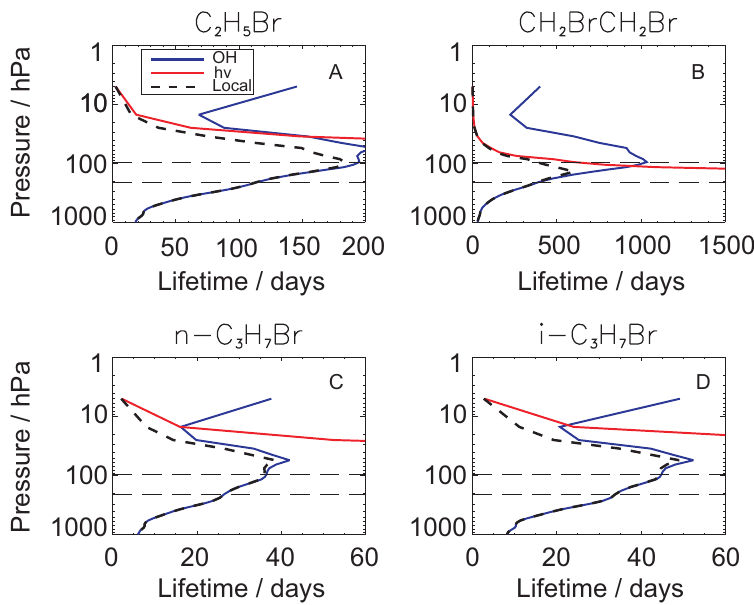
Fig. 5. Modelled mean local tropical lifetime (days) with respect to OH oxidation, photolysis and total for (A) C 2 H 5 Br, (B) CH 2 BrCH 2 Br,